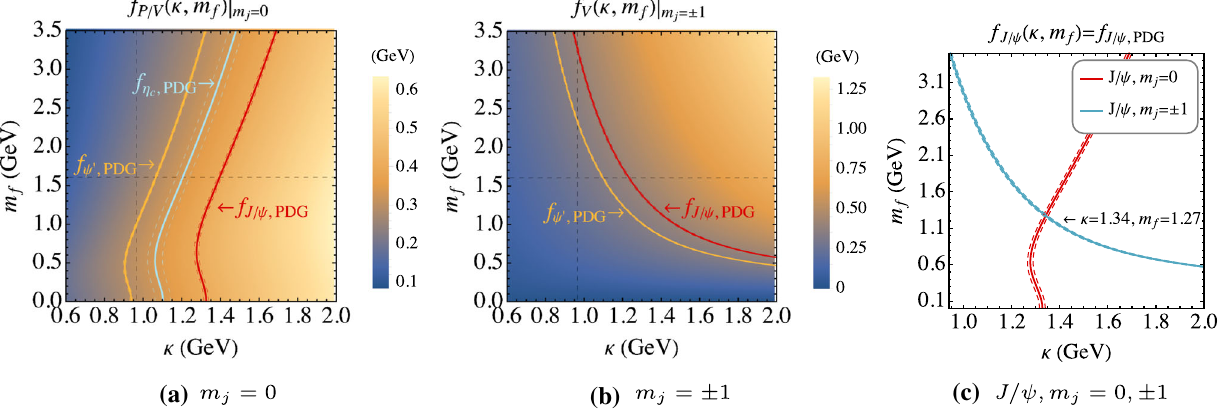
Fig. 4 Decay constant of η c , J /ψ and ψ (cid:2) as single-basis states [see Eq. (49) and the text], at different values of m f and κ . Panel a is calcu- lated from the m j = 0 state, and panel b is from the m j = ± 1 state. In each panel, the curves are the contours where the calculated decay con- stants equate to the PDG values in Table 3. There are three lines for each state,thesolidlineinthemiddleisthemeanvalue,andthetwoneighbor-